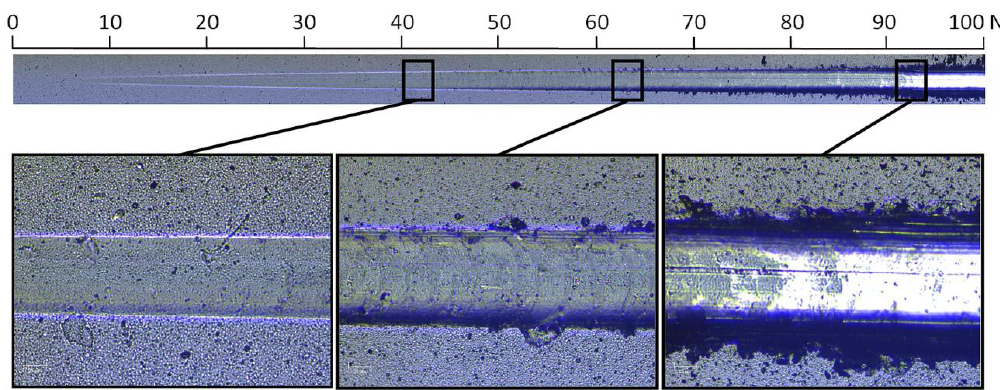
Figure 6. The scratch obtained in a scratch test performed on the coating deposited from the Al 69 Cr 30 Si 01 cathode and typical scratch adhesion damages at L c 1 = 42 N, L c 2 = 93 N and L c = 64 N.